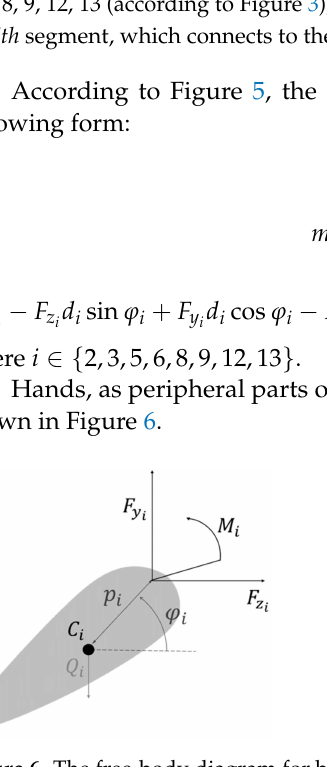
Figure 6. The free-body diagram for both hands. Used symbols stand for: i —segment number, which takes the value of 7 or 10 (according to Figure 3), and p i —the distance from the proximal end of the segment to the segment’s centre of mass ( C i